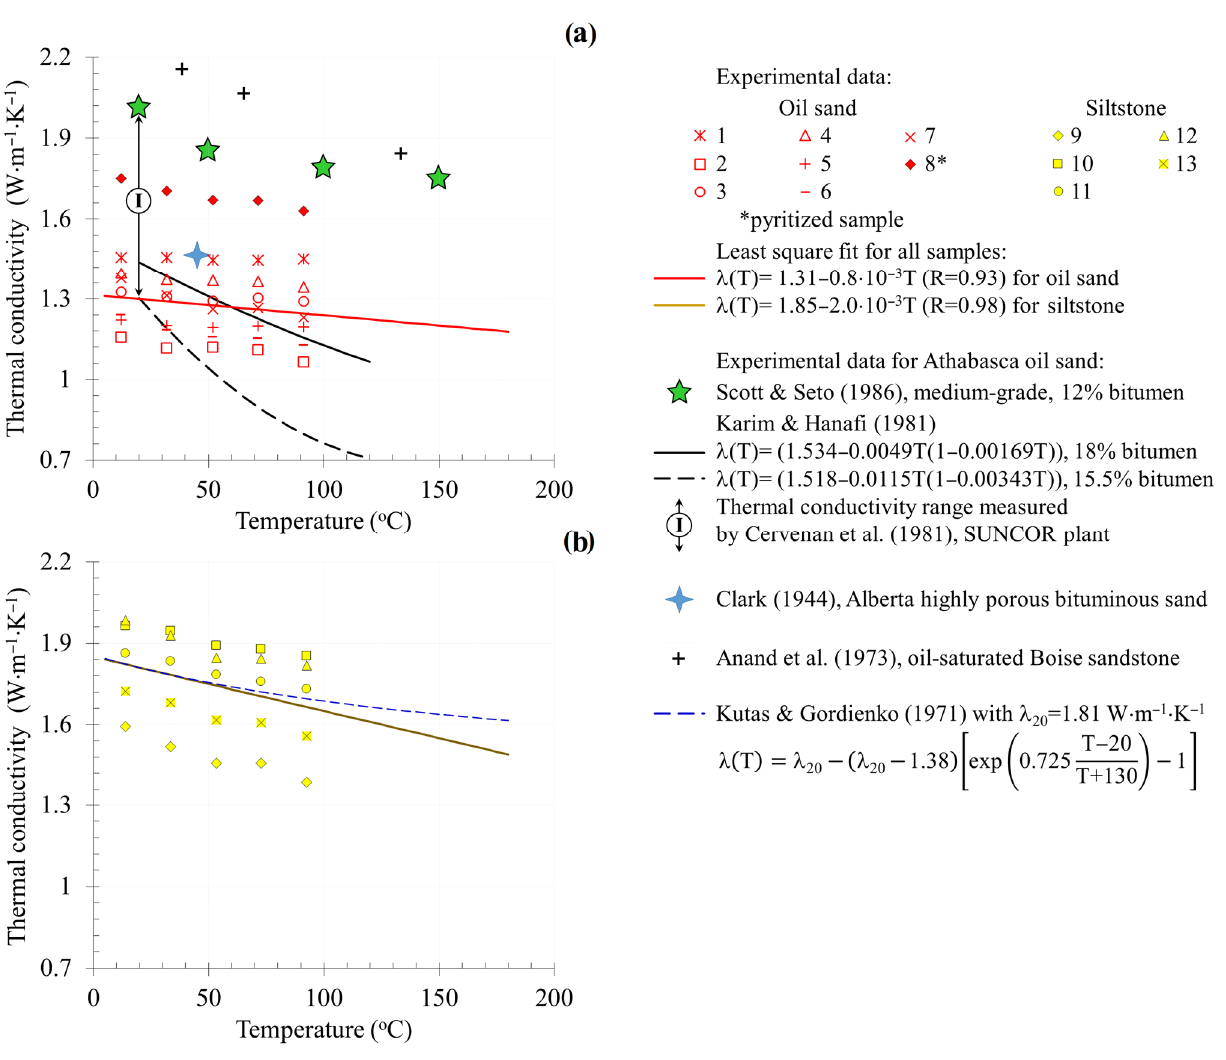
Figure 7. Temperature dependence for the thermal conductivity of ( a ) oil sand and ( b ) siltstone of the Karabikulovskoye field and comparison with some previously published results.